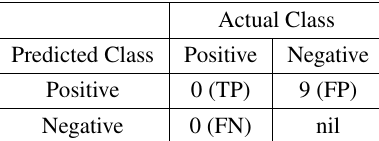
Table 1. Confusion matrix for no oil pad set, to see if the model returns any false detections.